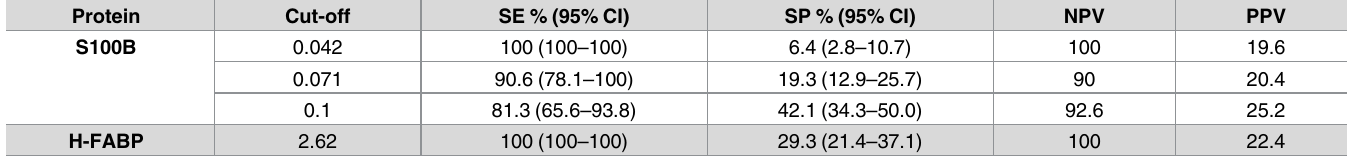
SE, sensitivity; SP, specificity; NPV, negative predictive value; PPV, positive predictive